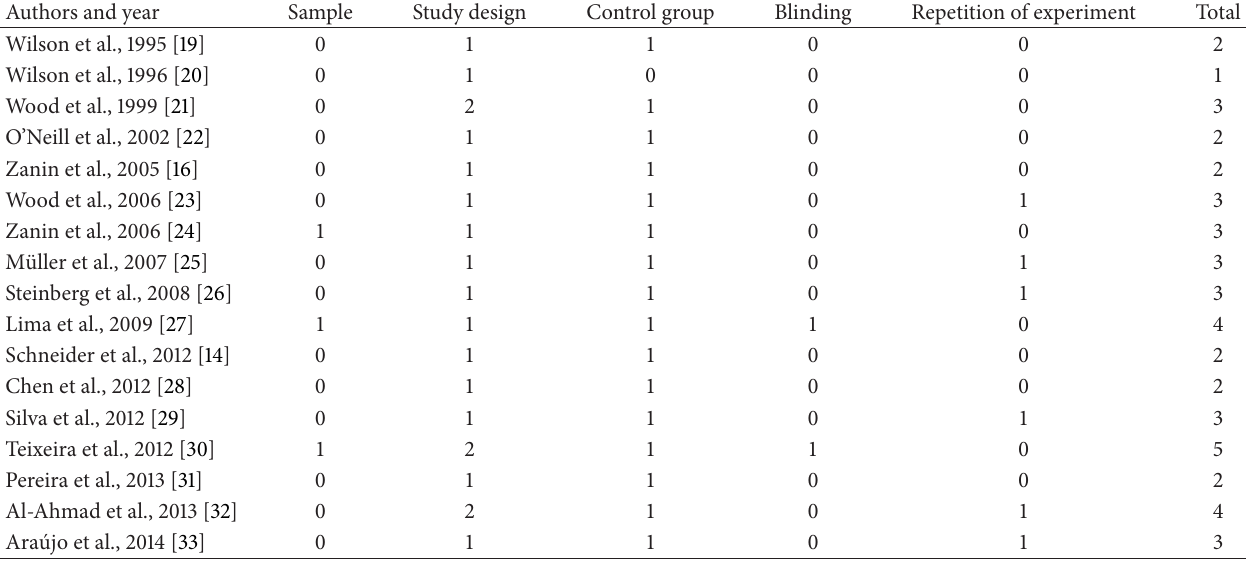
Table 1: Quality scores of articles selected based on proposed evaluation